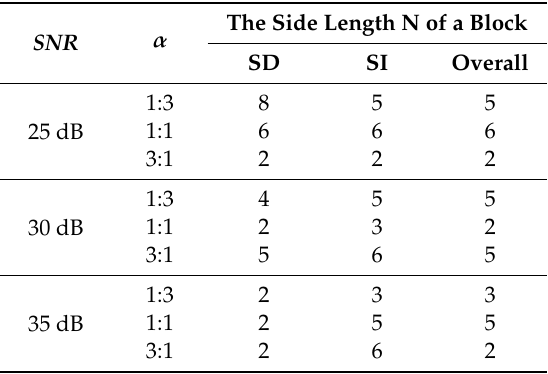
Table 3. The side length N of the optimal relative errors for the block-based MLRLS. The Side Length N of a Block SNR α SD SI